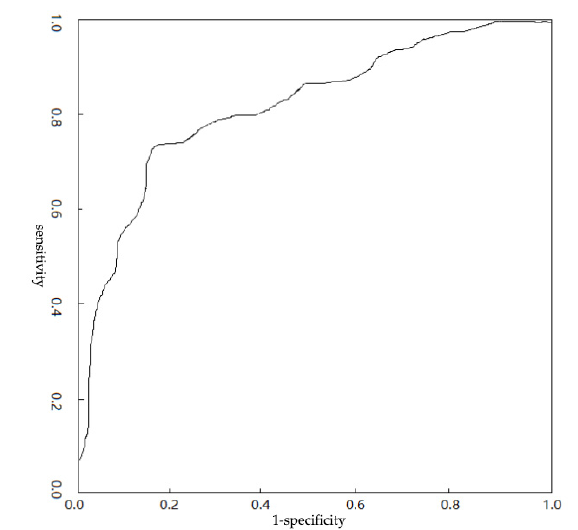
Figure 5. S-Cox-CSDPC disease prediction model ROC